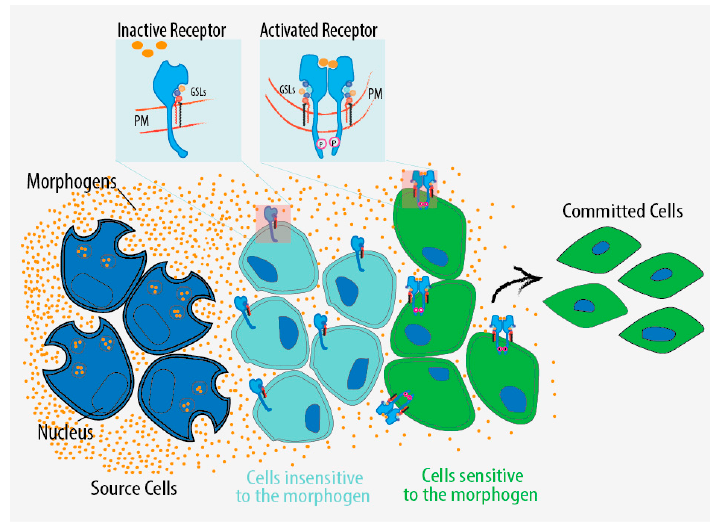
Figure 4. GSL regulation of signalling in development. Schematic representation of GSL-dependent regulation affecting the environmental sensing of the cell and the commitment to alternative differentiation fates. This regulatory layer might act in parallel to known mechanisms of tissue patterning such as morphogen gradients that induce the differentiation of specific cell types in a distinct spatial order. The same differentiation factor might be invisible to some cells and at the same time perceived by others depending on the fact that the target receptor is in a dormant or active state in relation to the GSL composition on the plasma membrane. Orange spheres represent morphogens; PM, plasma membrane.